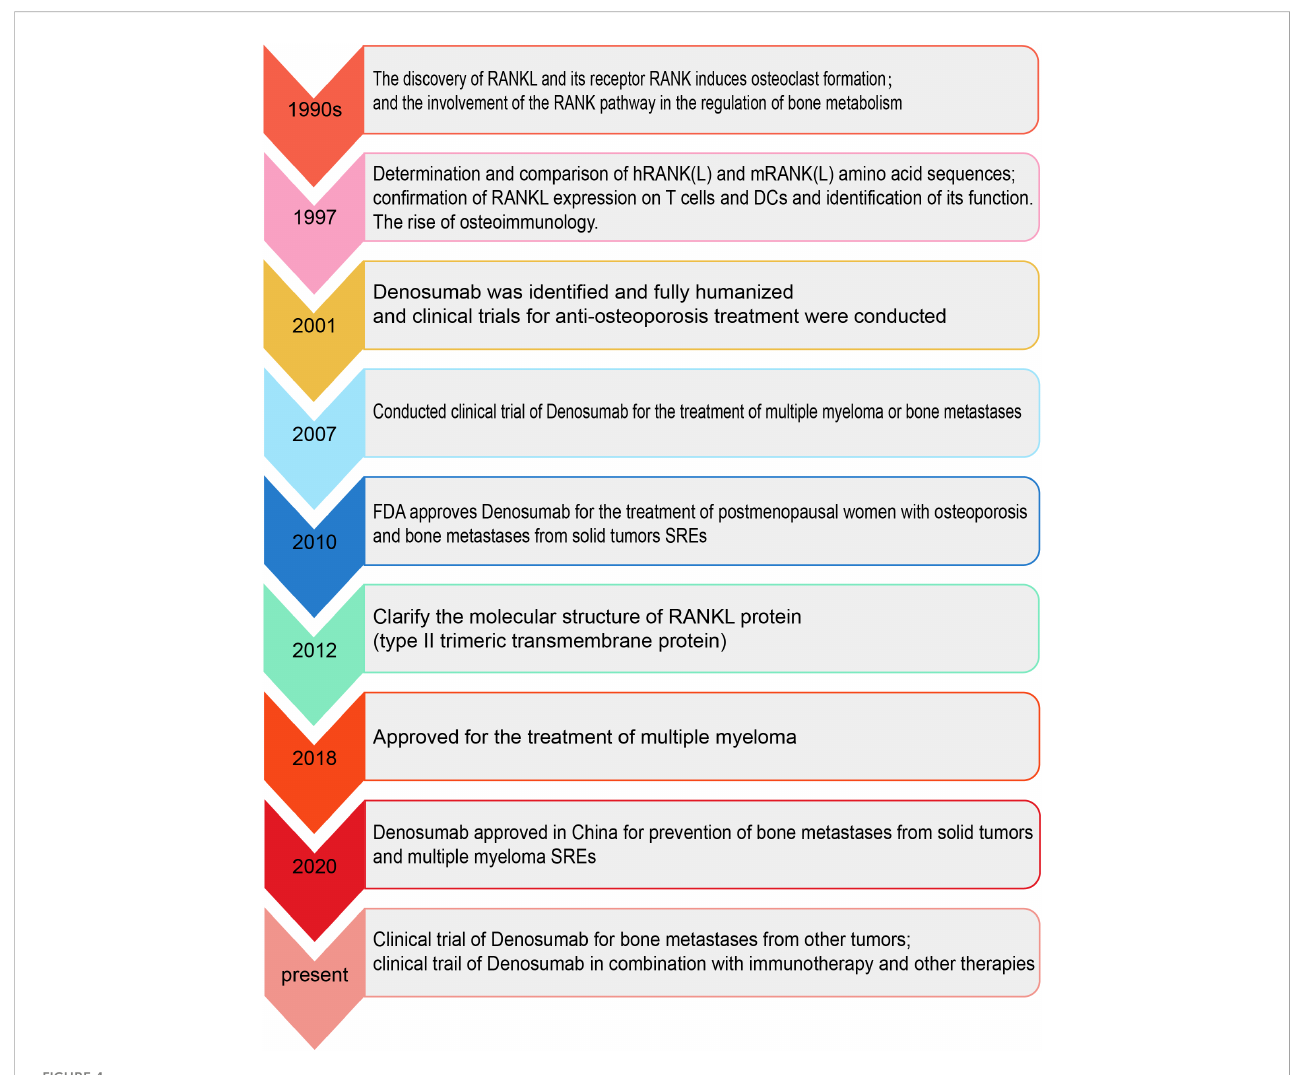
FIGURE 4 The timeline of RANK/RANKL/OPG system and denosumab. The chronological order shows the important events in the process from the discovery of the RANK/RANKL/OPG system and denosumab to its clinical